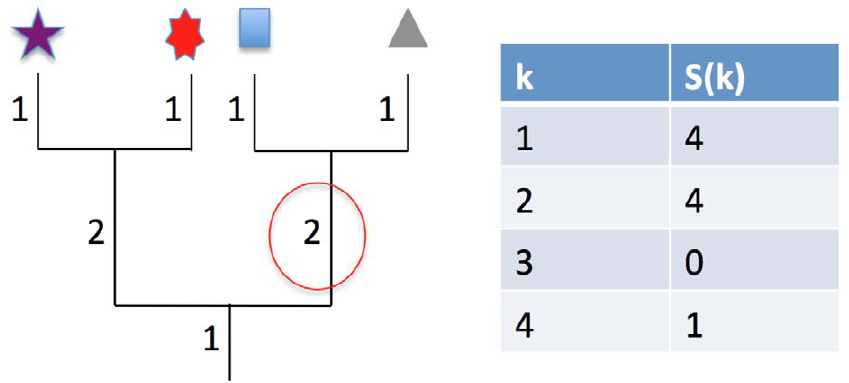
Figure 2. The Edge-length Abundance Distribution, S ( k ) , for a community with four individuals. All edges are labeled by their length, and the table shows the total edge-length summed across all edges with a given number of upstream tips. Number of tips appears in the left column, and the total edge-length associated with that number of tips, S ( k ) , is shown in the right column. For example, the circled edge has length two, and has two tips downstream, and therefore contributes length 2 to S (2) .